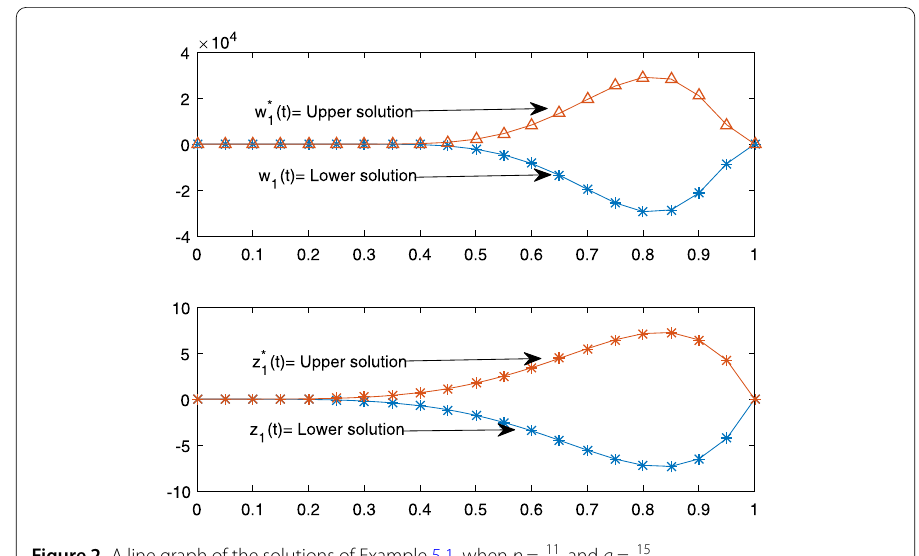
Figure 2 A line graph of the solutions of Example 5.1, when p = 11